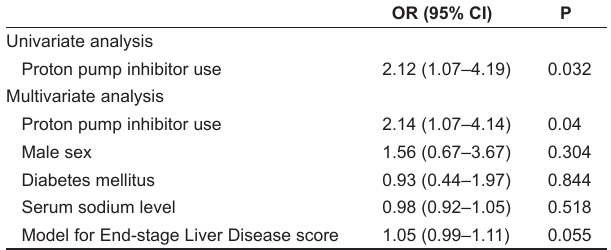
TAble 3 Risk factors for spontaneous bacterial peritonitis